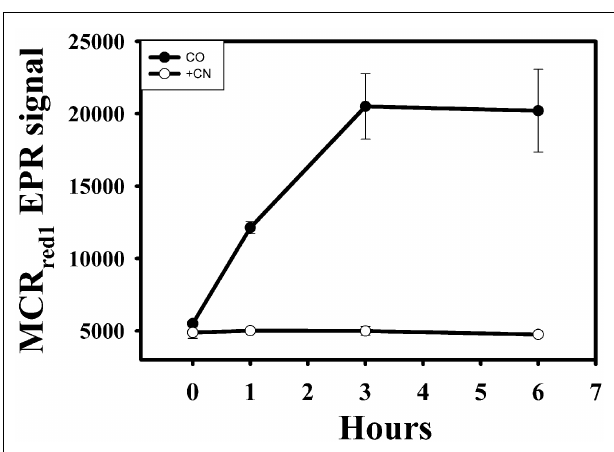
FIGURE 3 |Activation of MCR by CO in the presence of CODH inhibitor, CN − . Filled circles, CO-purged samples; open circles, CO-purged samples in the presence of 0.2 mM CN −